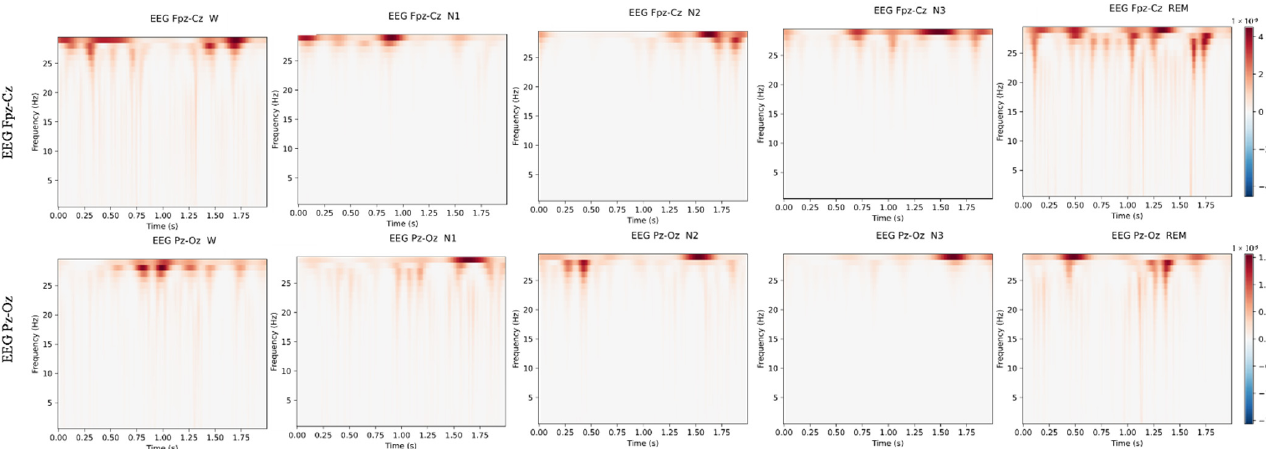
Figure 7. Power spectral density plot of the EEG Fpz-Cz channel and the EEG Pz-Oz channel interception for the W, N1, N2, N3, and REM stages.